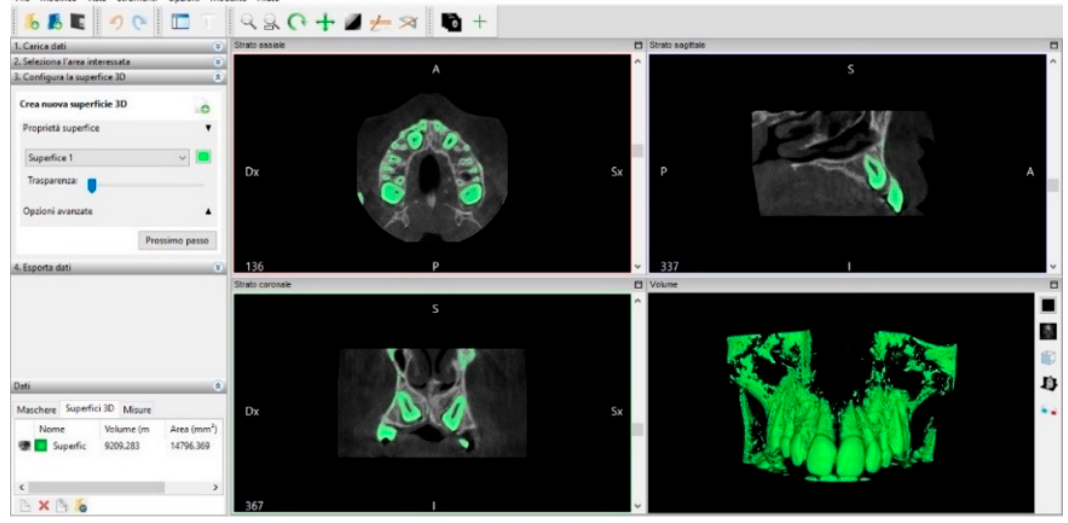
Figure 2. 3D model generated on Invesalius 3.